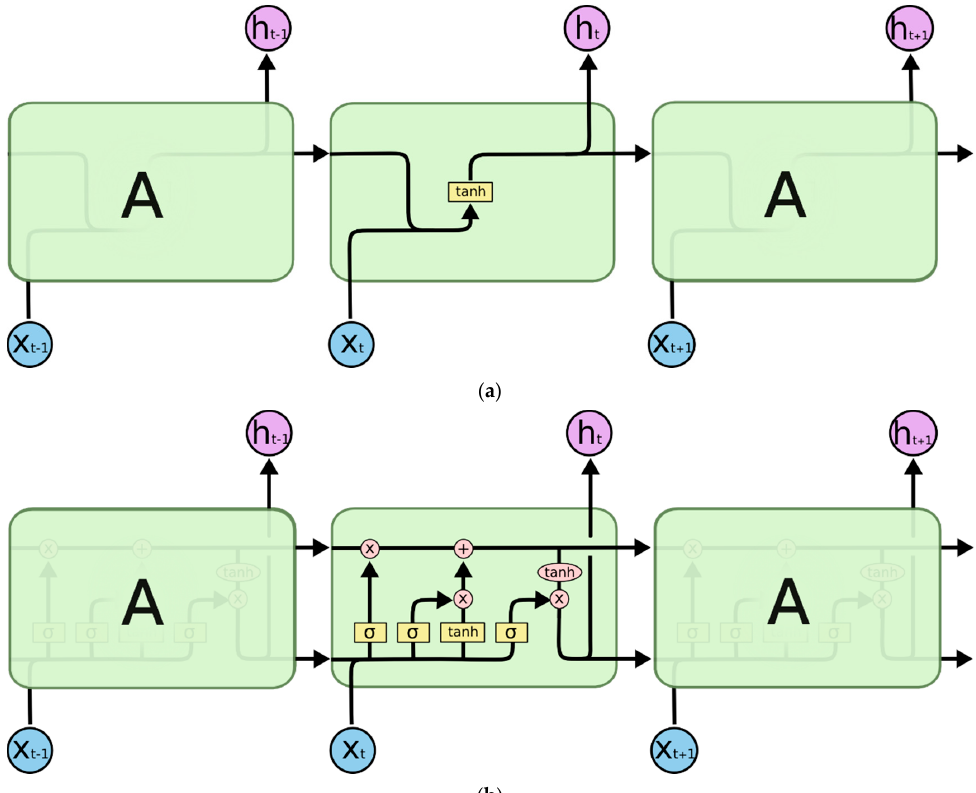
Figure 2. The repeating modules of RNN and LSTM. ( a ). The repeating module in a standard RNN contains a single layer; ( b ). The repeating module in an LSTM contains four interacting layers (A is a chunk of neural network).